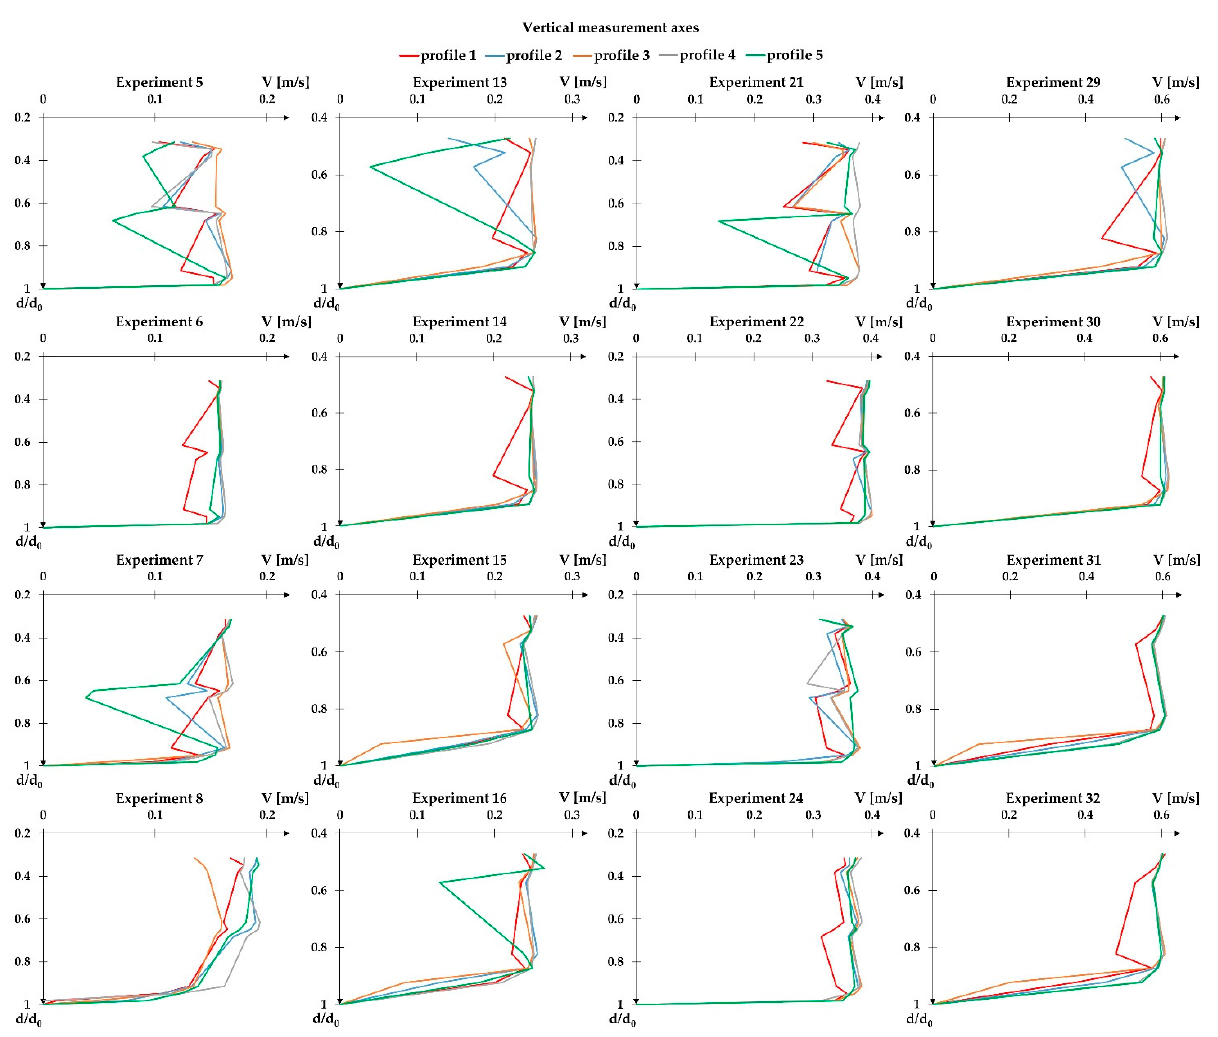
Figure 6. Composite graph of the flow velocity profile for each vertical measurement axis on XS-US for configurations C5–C8 (from top to bottom). for configurations C5–C8 (from top to